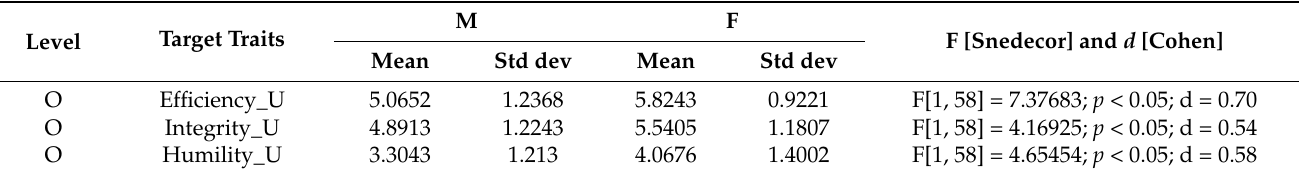
Table 6. Means and effects of gender on the social valuation of traits.